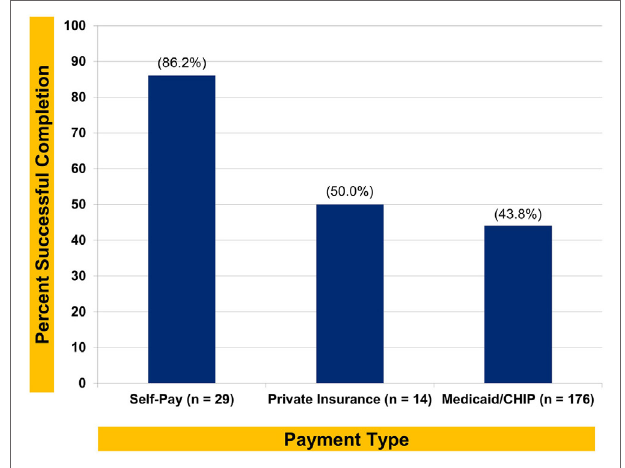
FigUre 1 | Successful orthodontic completion rate by payment